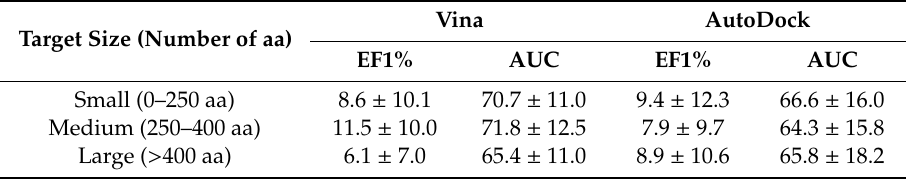
Table 3. Performance of Vina and AutoDock in the discrimination between ligands and decoys for the targets of di ff erent sizes based on the number of amino acid residues of each target (number of